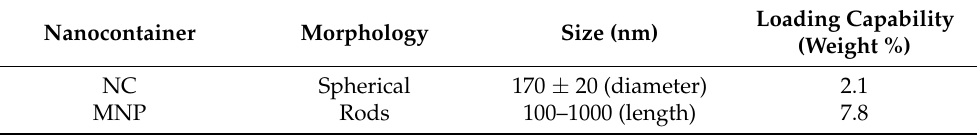
Table 1. Properties of silica nanocontainers loaded with ZS.